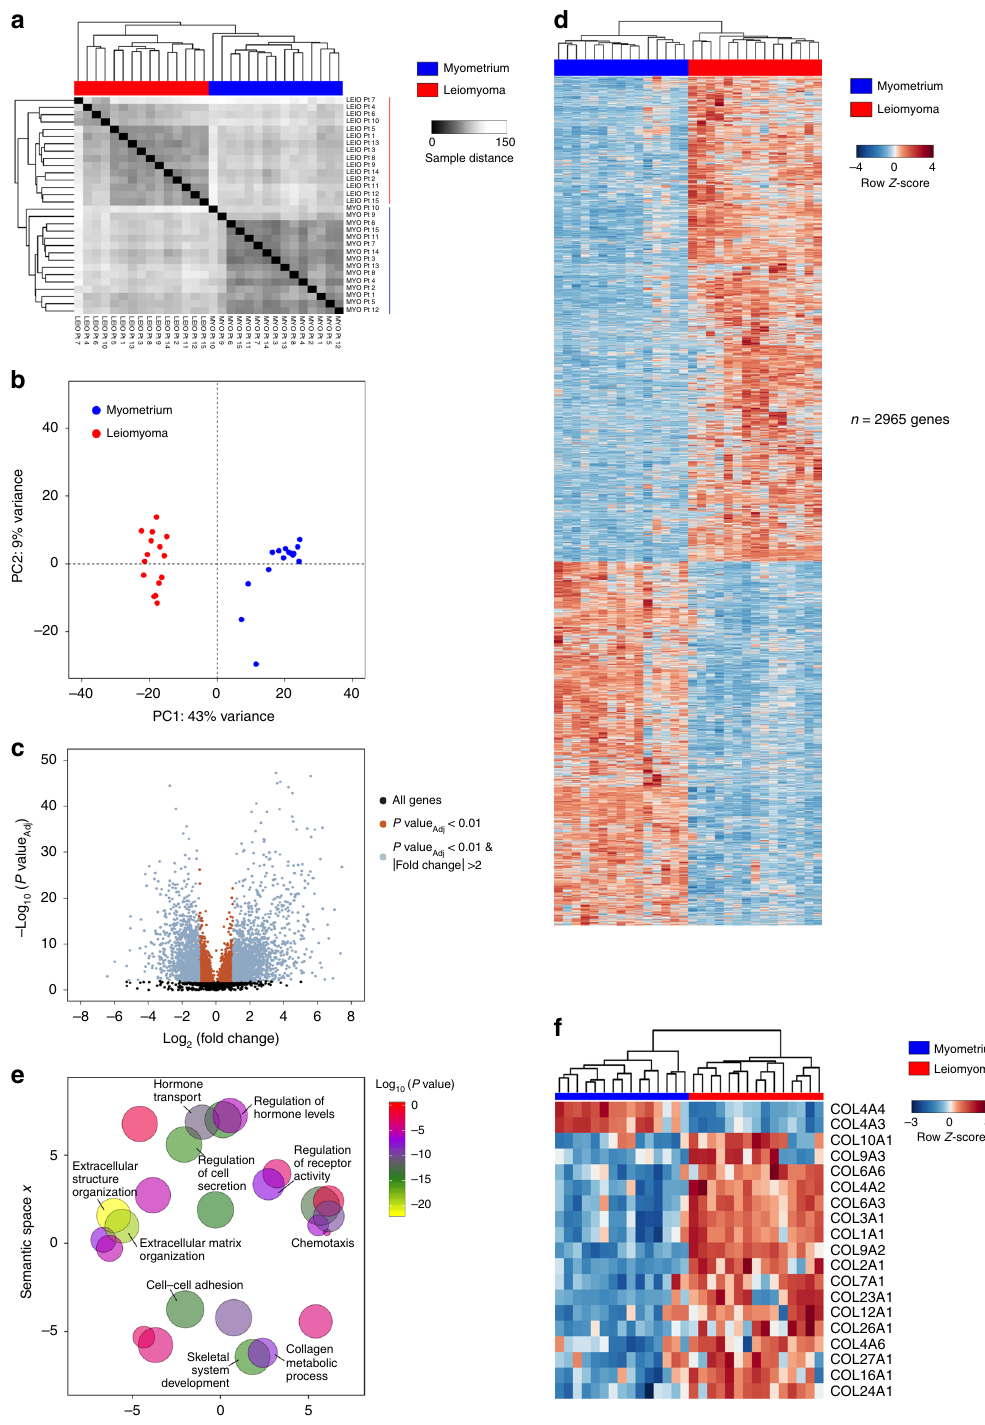
Fig. 1 Transcriptome pro fi ling reveals transcriptional dysregulation of key biological processes in fi broids. a Heat map representing tissue sample Euclidean distance matrix clustering of RNA-sequencing pro fi les for 15 patients. b Principal component analysis plot of the top 500 most variable genes in myometrium and leiomyoma tissue samples. First two principal components are plotted. c Volcano plot of all differentially expressed genes (sienna, n = 5831) and differentially expressed genes with >2-fold change (gray, n = 2965) in myometrium and leiomyoma (FDR < 0.01, BH-corrected Wald test). Unchanged transcripts (FDR > 0.01) are shown in black. P values are truncated at 1 × 10 − 50 for visualization purposes. d Heat map of differentially expressed genes with >2 fold change in myometrium (blue) vs. leiomyoma (red) tissue samples. Gene expression levels relative to the mean expression are shown as row Z -scores ( n = 2965 genes). e Scatter plot of con fi dence scores for enriched gene ontologies associated with differentially expressed genes, with ontologies clustered by functional similarity in the semantic space. f Hierarchically clustered heat map of differentially expressed collagen genes. Gene expression levels relative to the mean expression are shown as row Z